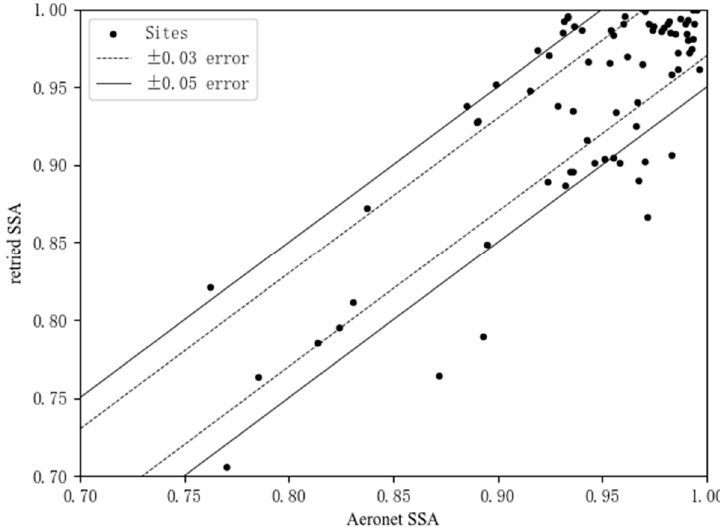
Figure 8. Comparison of estimated SSA from the ANN model and SSA from AERONET. Note: each dot represents a line of data where the AERONET observations spatiotemporally matched MODIS data. The observations from Belsk and Skukuza sites were highlighted using square and triangle marks, respectively.